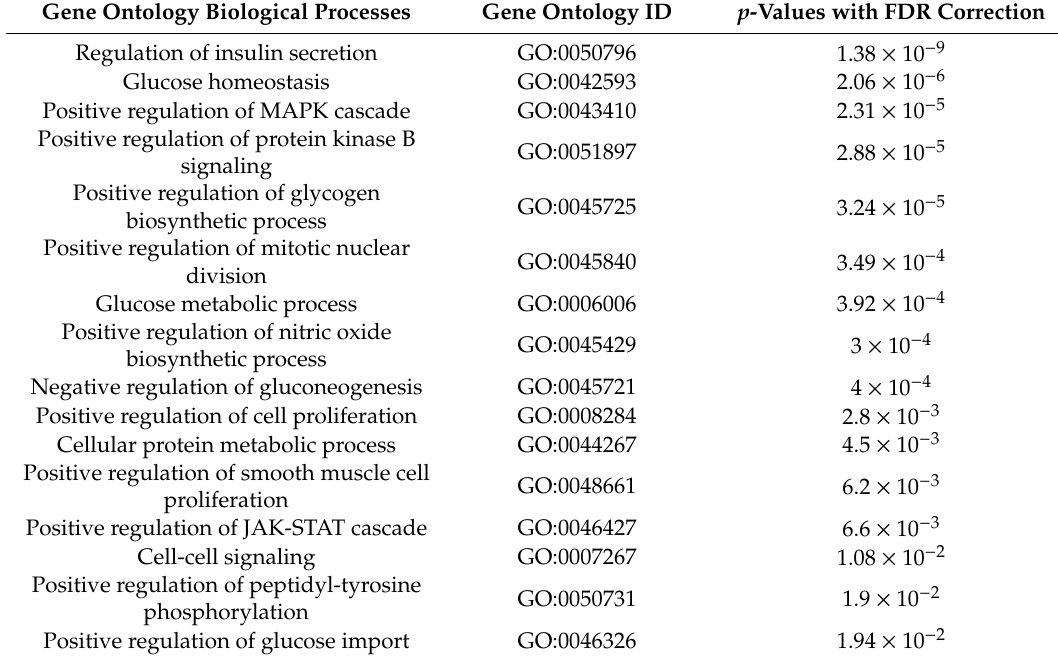
Table 2. Gene Ontology biological processes overrepresented ( p -values with false discovery rate (FDR) correction < 0.05) for a group of GV-related genes, identified with the DAVID